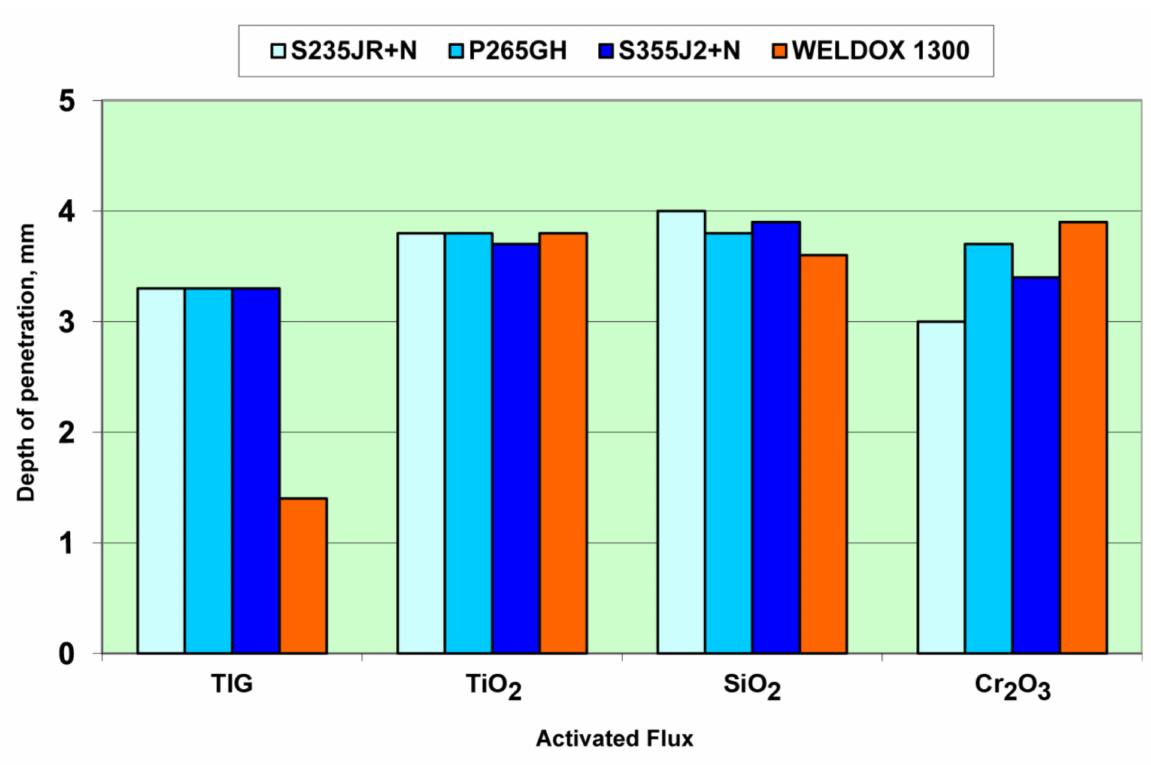
Figure 10. The penetration depth of the welds on steel S235JR+N, S355J2+N, P265GH, and WELDOX 1300, made using TiO 2 , SiO 2, and Cr 2 O